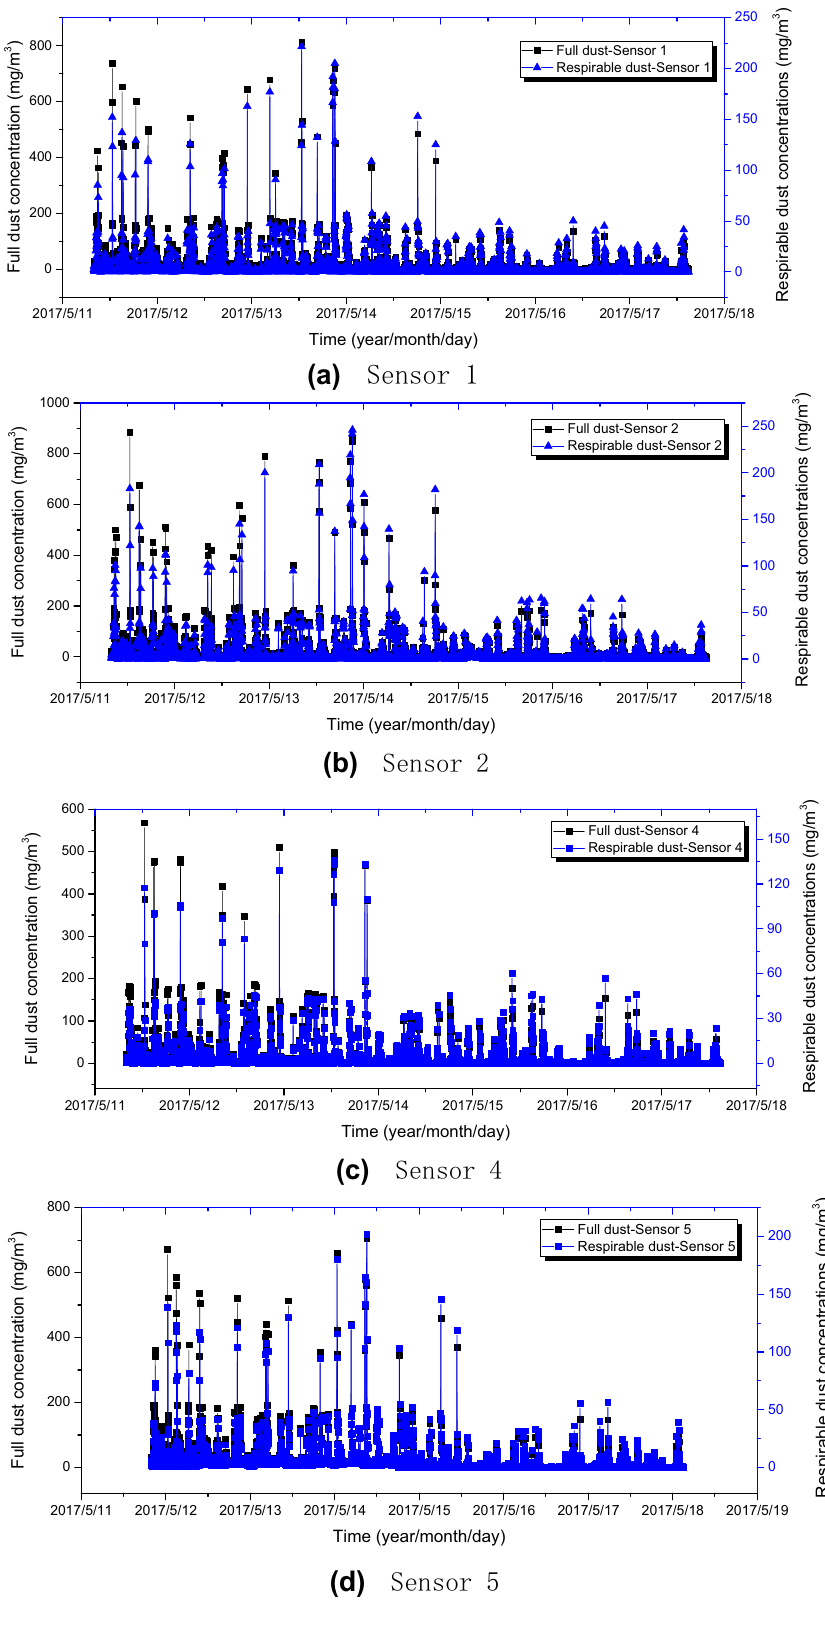
(a) (cid:3)(cid:54)(cid:72)(cid:81)(cid:86)(cid:82)(cid:85)(cid:3)(cid:20)(cid:3)